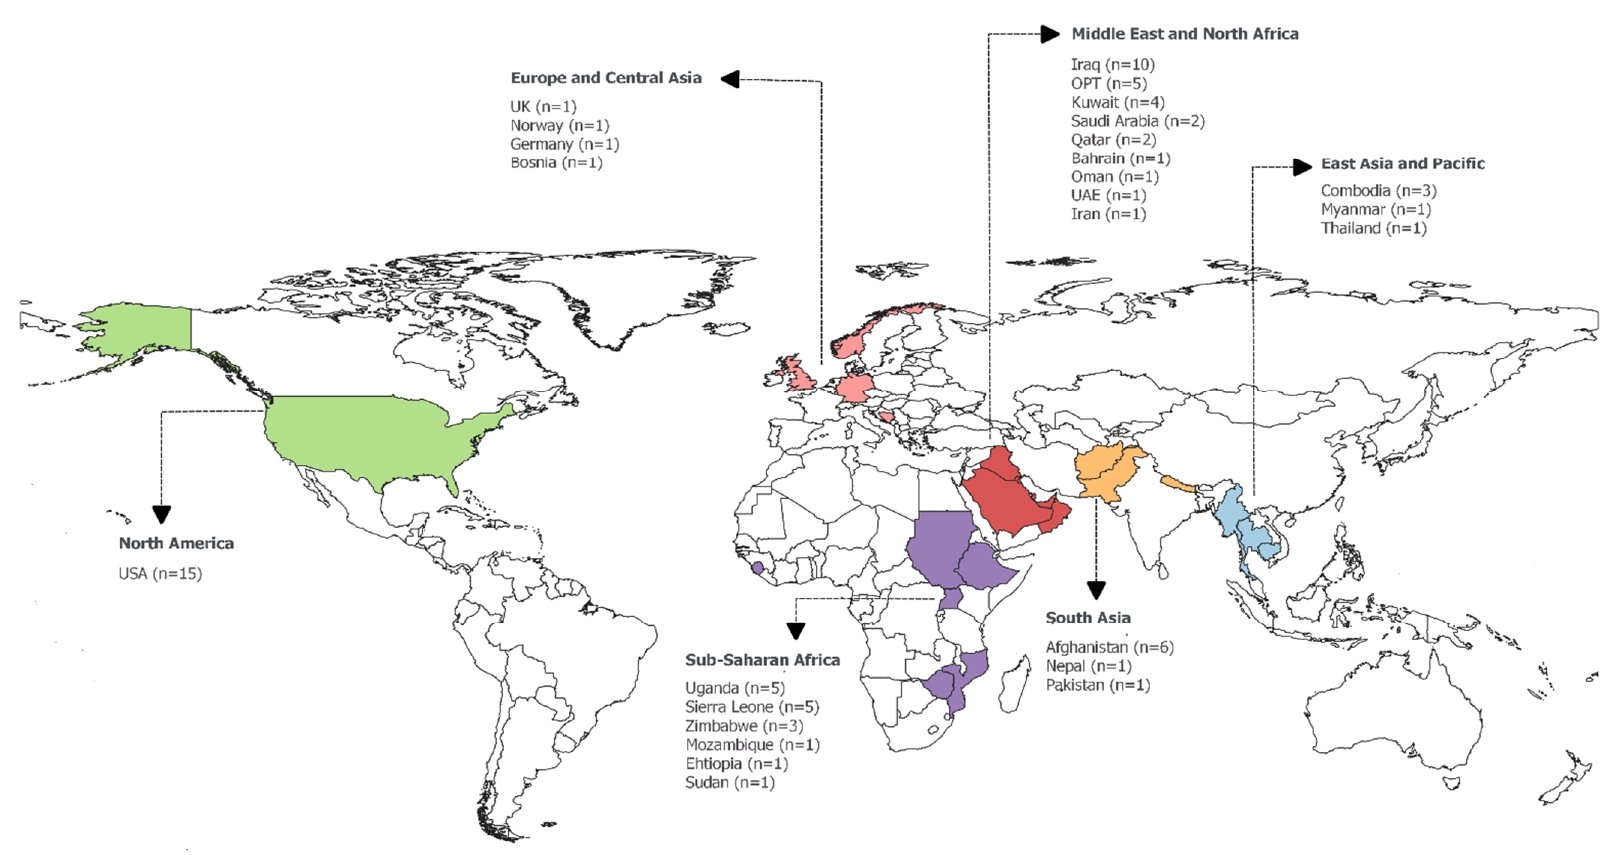
Figure 2. Geographical distribution of the included studies. “n” denotes the number of publications in each country; OPT: Occupied Palestinian Territories; UAE: United Arab Emirates; UK: United Kingdom; USA: United States of America.